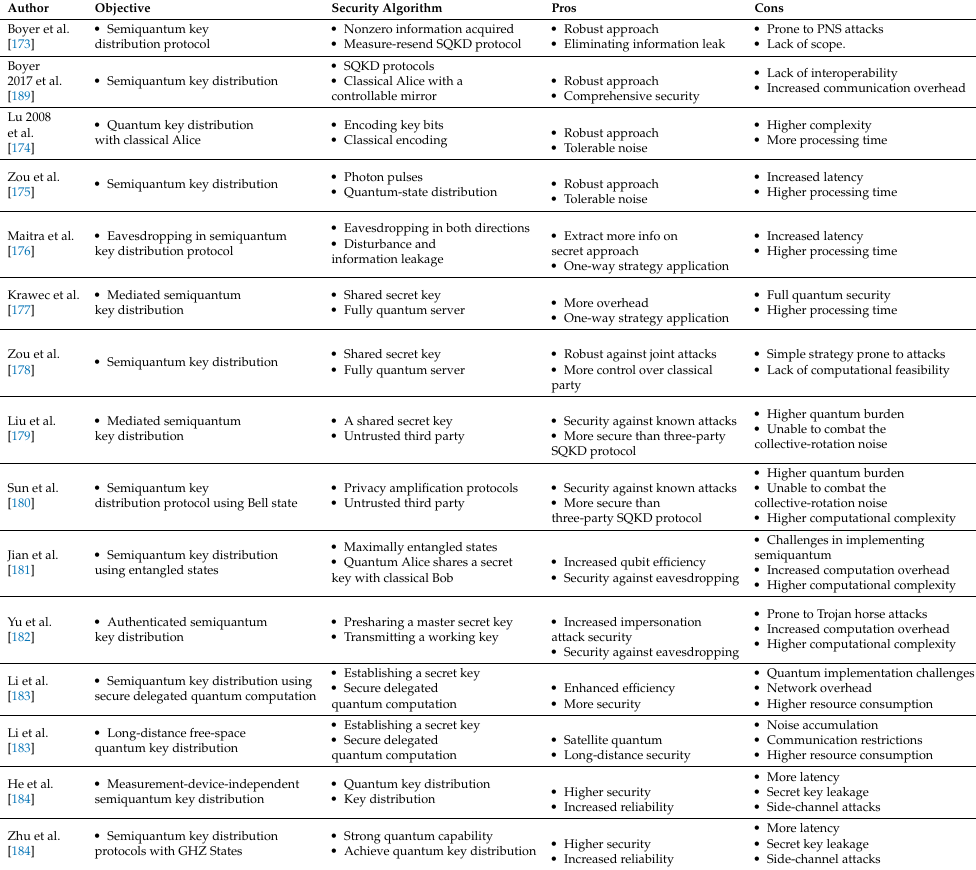
Table 9. Summary of countermeasures and security protocols using Semiquantum Key Distribution